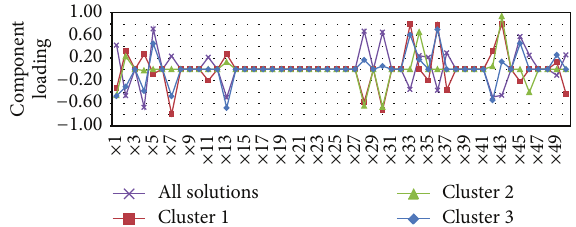
Figure6:Distributionofthecomponentloadingsforthefirstdesign mode of each cluster.